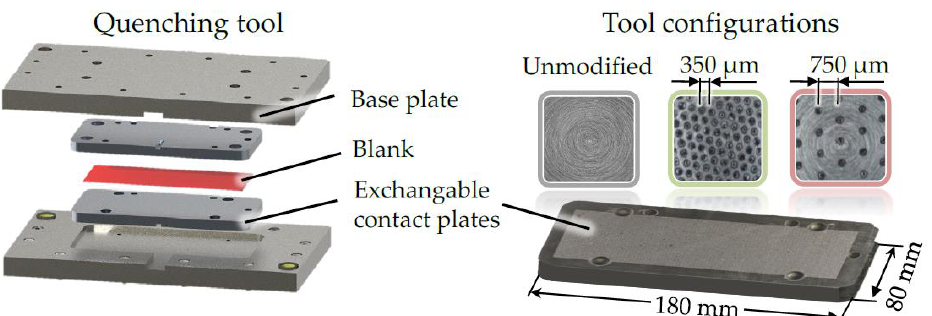
Figure 5. Tooling setup and modified contact plate for analyzing the cooling behavior.